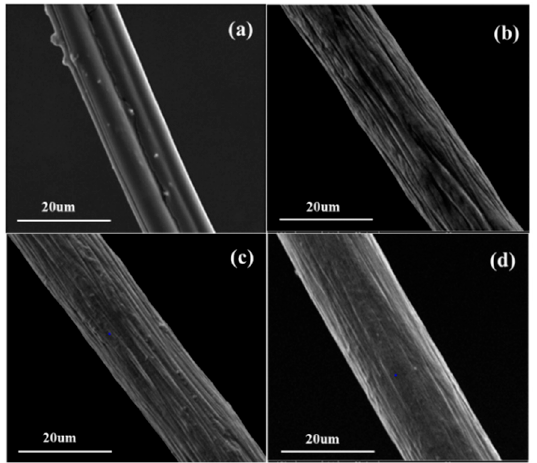
Figure 2. SEM surface image of ( a ) collagen protein viscose, ( b ) modified PAA, ( c ) modified PEA, ( d ) modified PAN.